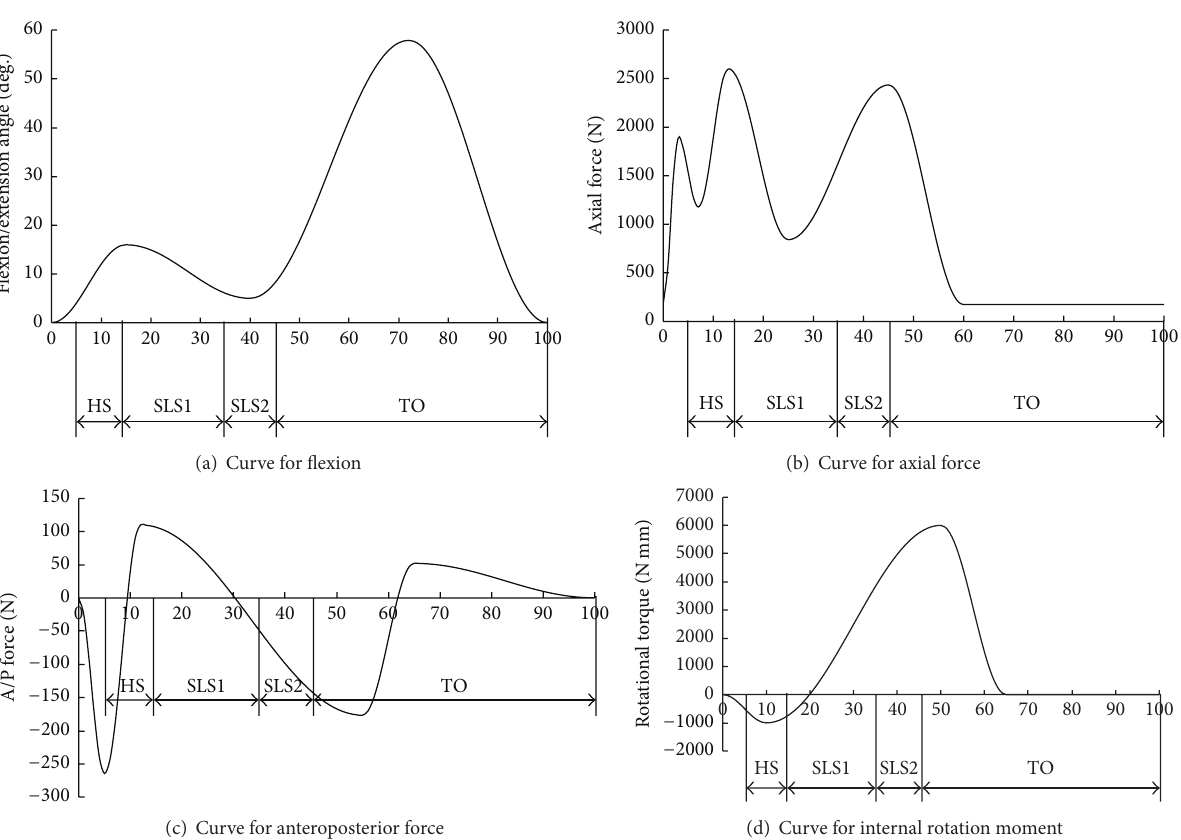
Figure 2: The distribution of gait loading curves during gait